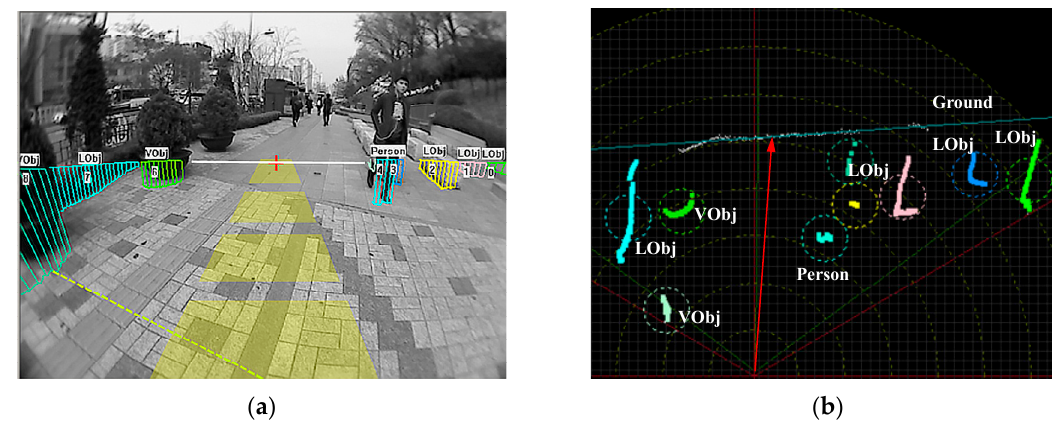
Figure 3. Near-field sensing scenario. ( a ) Near-field sensing result in the image domain; ( b ) Near-field sensing result in the range data domain.